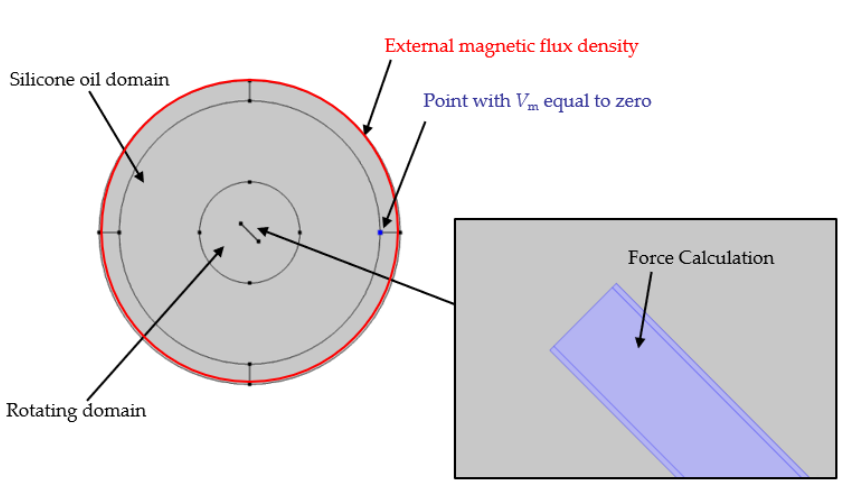
Figure 6. Settings of the boundary conditions and the load for the magnetostatic simulation (stage 1).